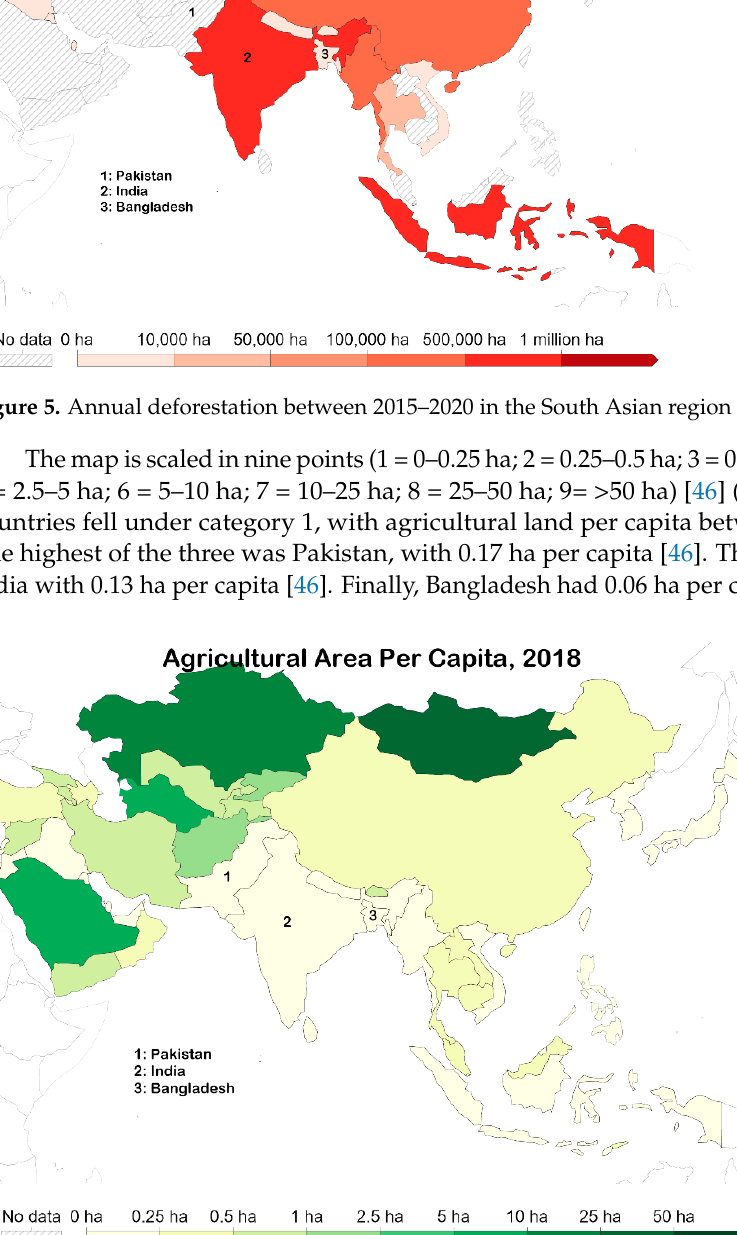
Figure 5. Annual deforestation between 2015–2020 in the South Asian region [46].